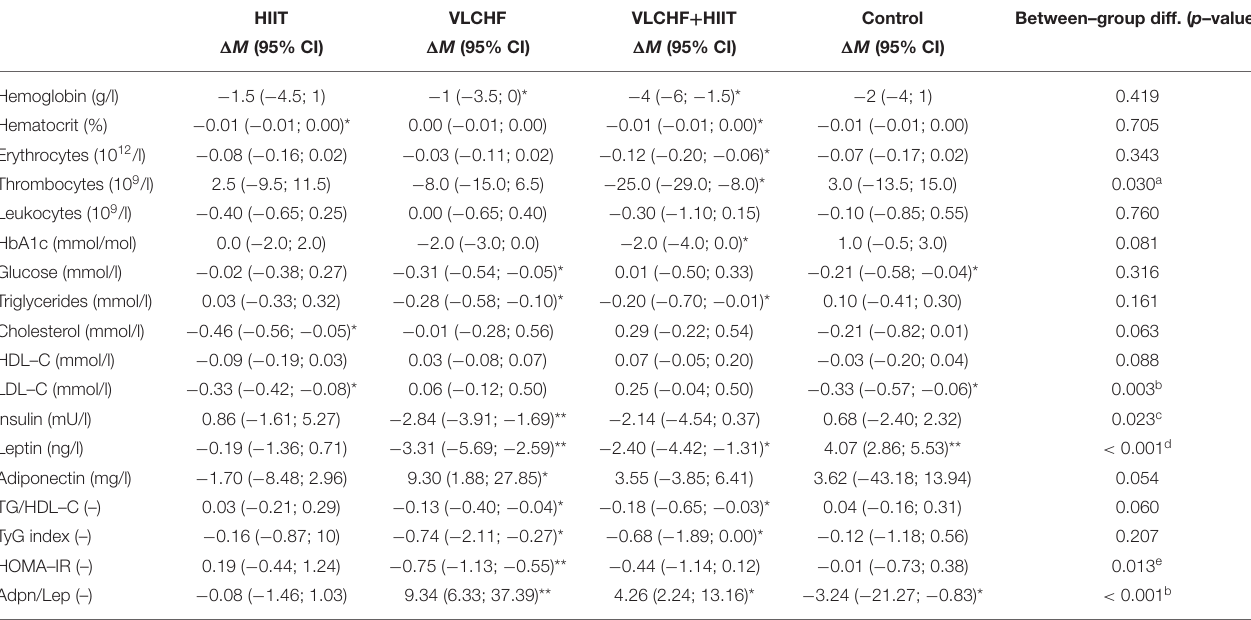
TABLE 2 | Biochemical variables differences after 12 weeks. HIIT VLCHF VLCHF + HIIT Control Between–group diff. ( p